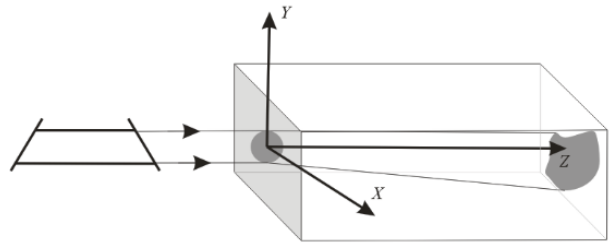
Figure 1. Layout of numerical experiments.